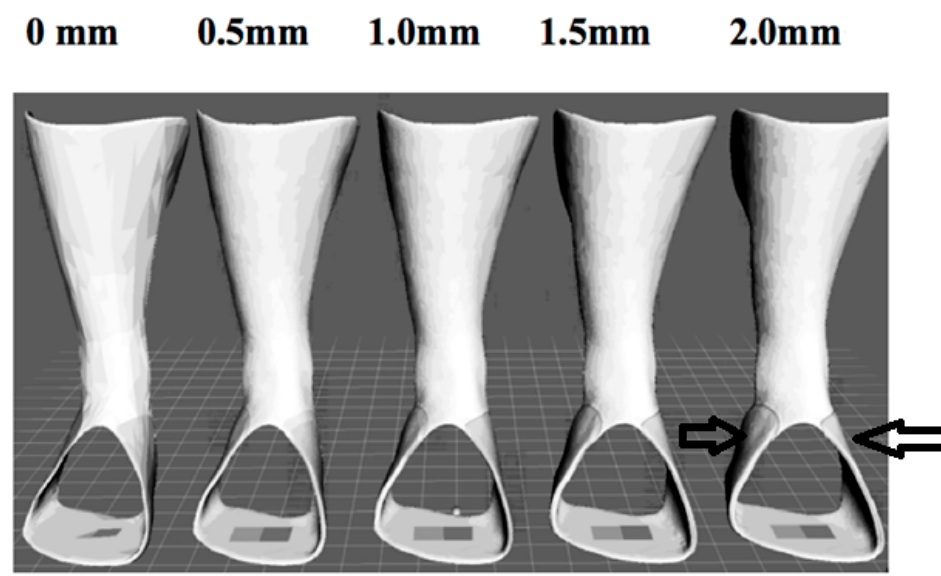
Figure 4. Di ff erent thicknesses around the neck of five AAFO models. The arrow indicates the location of increasing thickness.